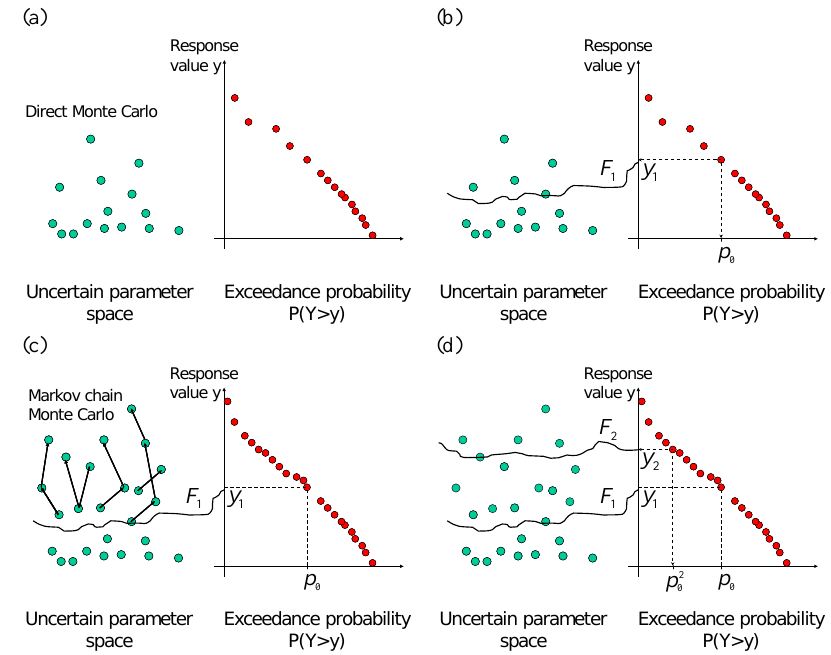
Figure 3. Schematic of subset simulation procedure: (a) level 0 (initial phase) sampling by direct MCS, (b) determination of level 1 samples F 1 given conditional exceedance probability p 0 , (c) populating conditional samples in level 1 by MCMC procedure, and (d) forwarding algorithm to subsequent conditional levels until the target exceedance probability p f = p N